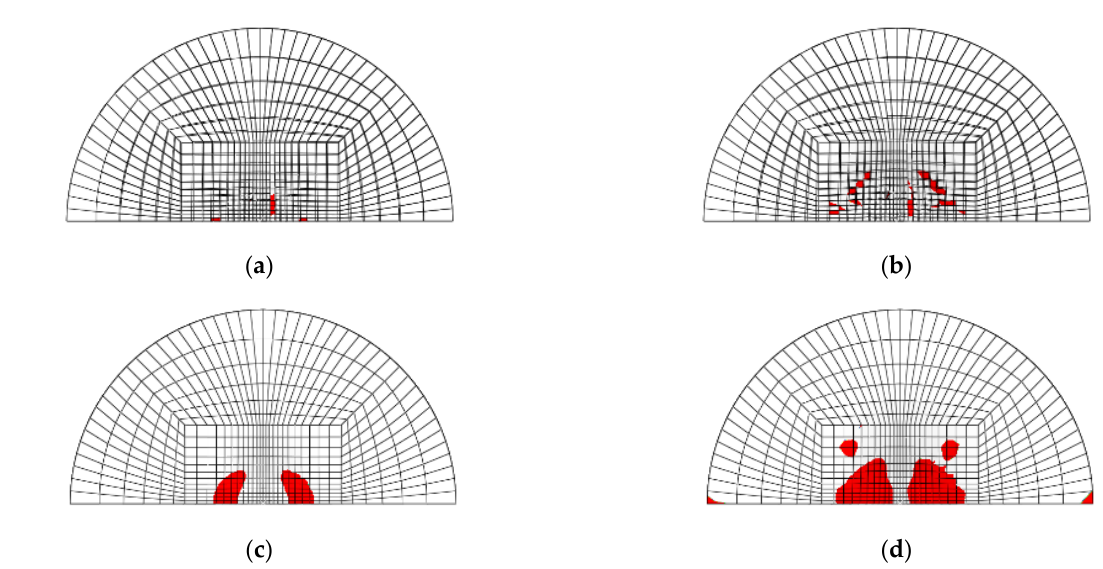
3D failure model (3.4 ms).